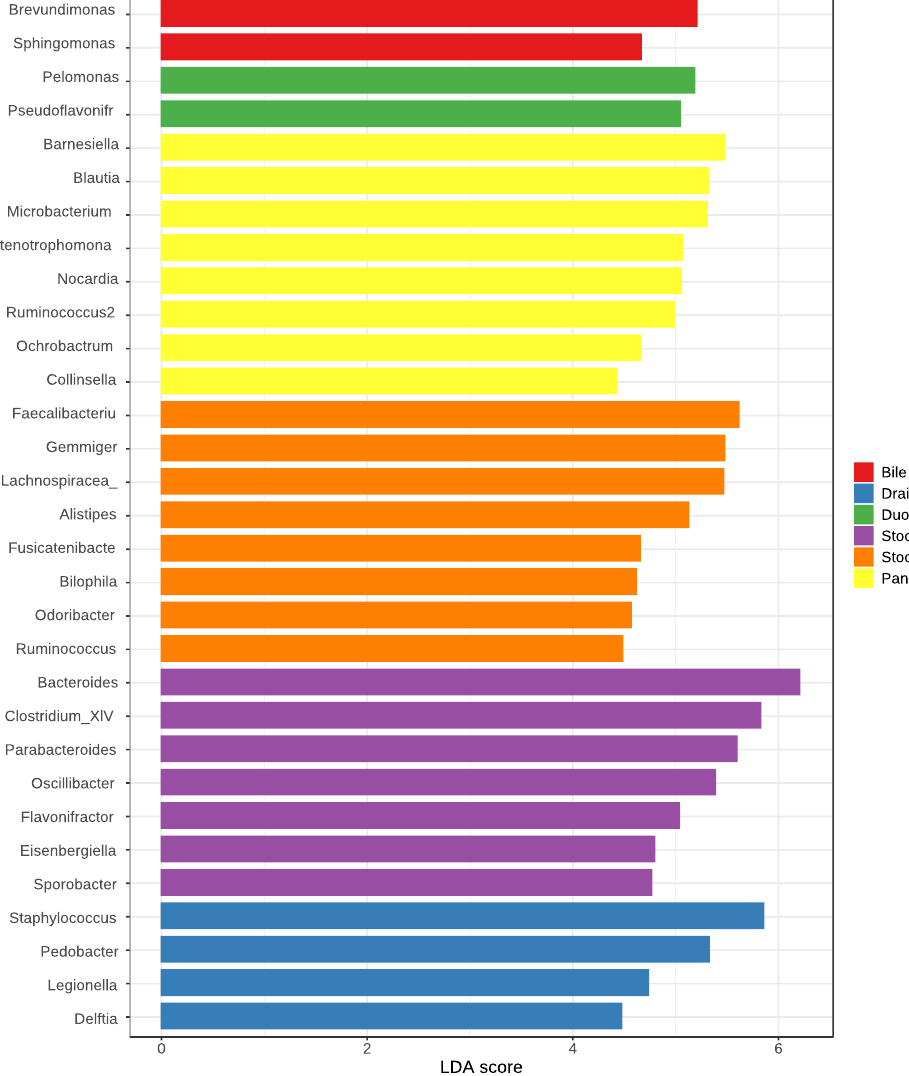
Figure 3. Analysis of key genera of the microbiota in the different body site compartments using linear discriminant analysis (LDA) coupled with effect size measurements (LefSe) analysis.